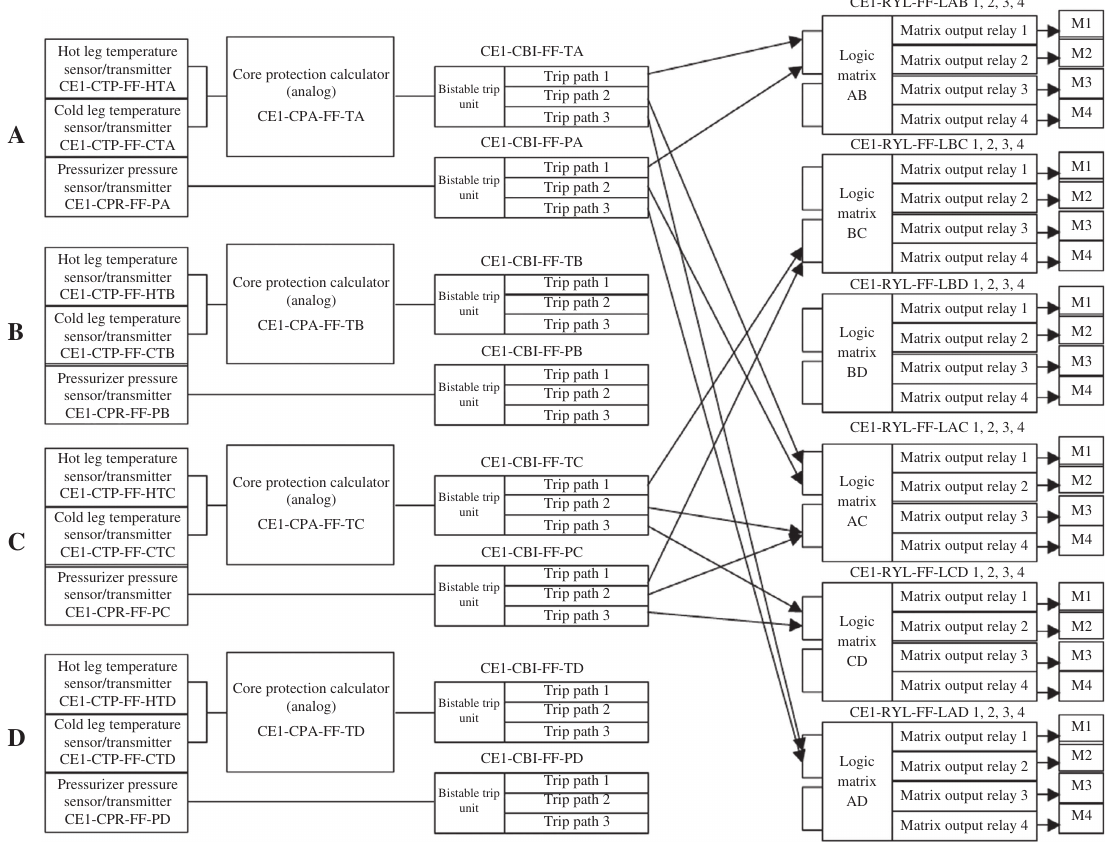
Figure 1: Simplified Diagram of the U.S. CERPS Group 1